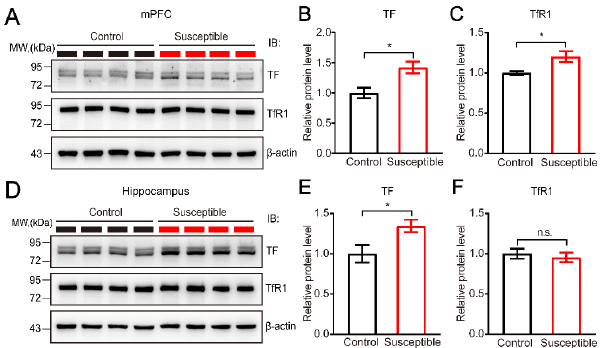
Figure 4. Delivery of exogenous TF peripherally across the blood brain barrier into the brain. ( A ) Schematic diagram of red transferrin conjugate delivery and imaging. ( B ) Red fluorescence signals were detected in multiple tissues including liver, heart, spleen, lung and kidney of injected mice ( n = 3). ( C ) Red fluorescence signals were detected in the central brain including mPFC, vHip, dHip, Hb and BLA of injected mice ( n = 3). mPFC, medial prefrontal cortex; vHip, ventral hippocampus; dHip, dorsal hippocampus; Hb: habenular; BLA, basolateral amygdala.